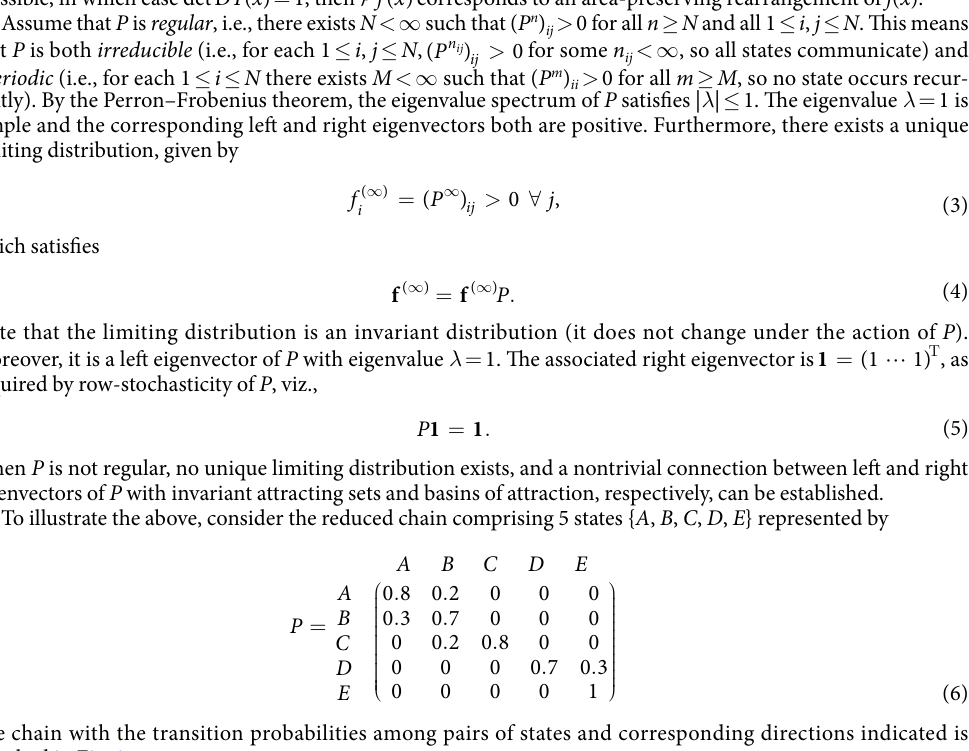
# of particles in that are mapped to = . P